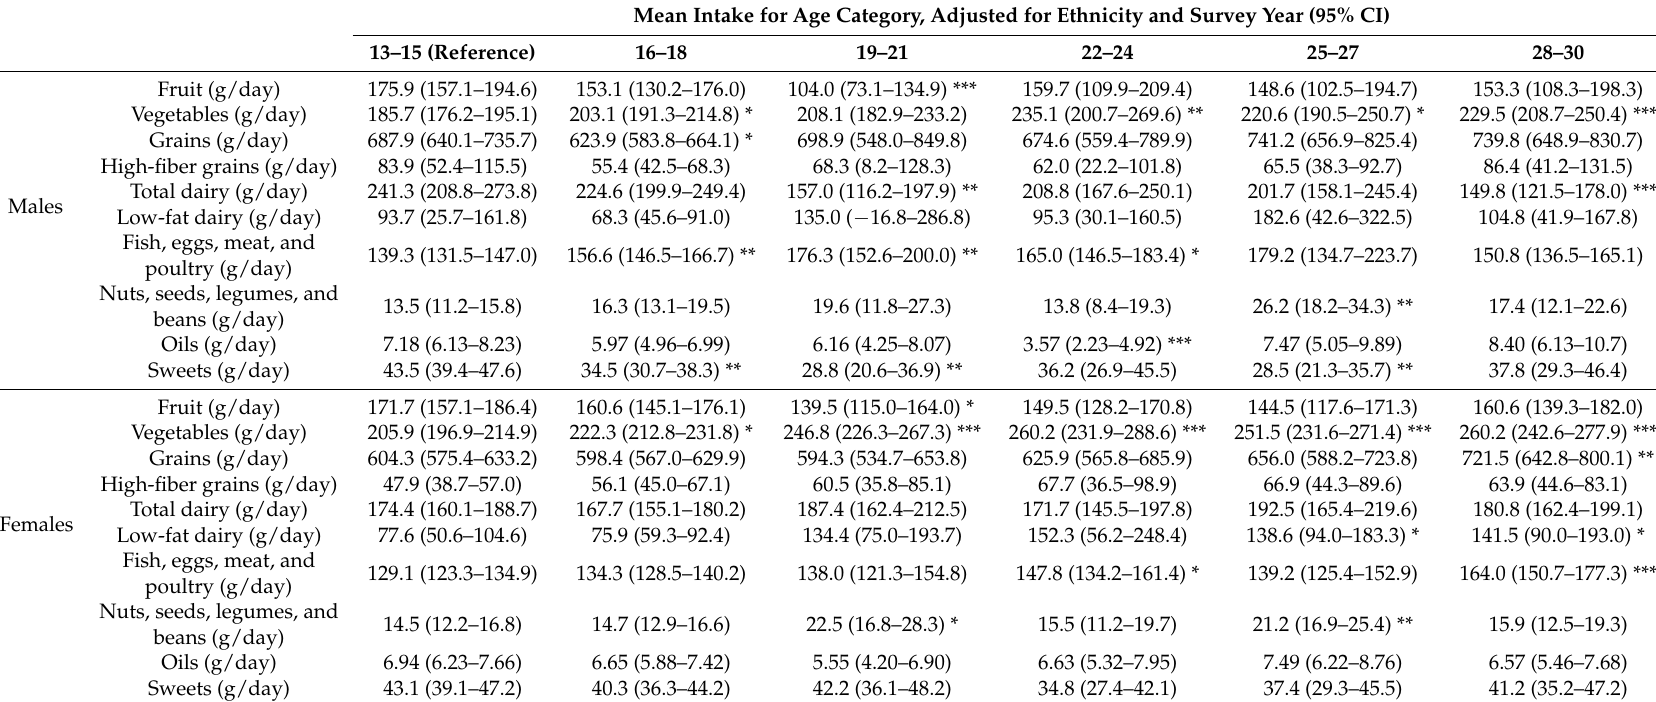
Table 2. Intake of DASH index component food groups, by age category, NDNS Rolling Programme years